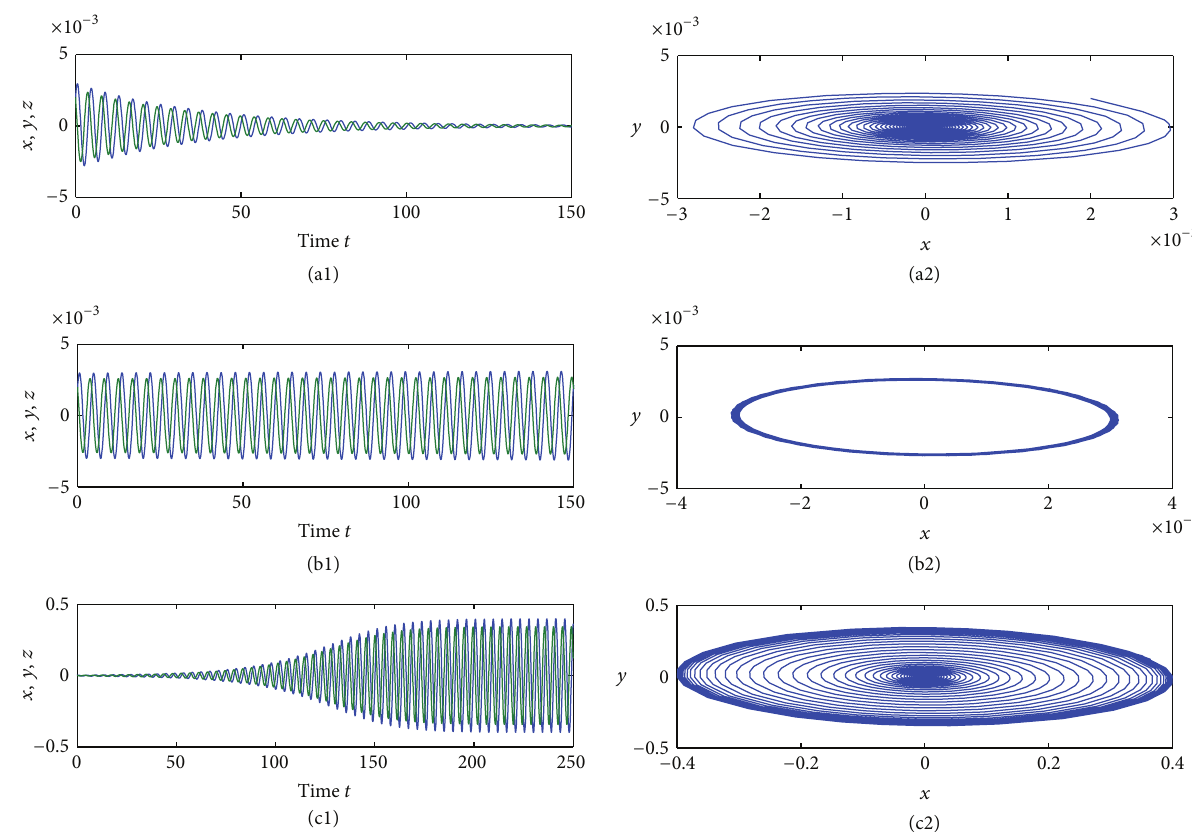
Figure 4: Time histories (a1, b1, and c1) and phase trajectories (a2, b2, and c2) of system (3) before, during, and after Andronov-Hopf bifurcation. In (a1) and (a2), 𝜏 = 0.233164320601144 < 0.253164320601144 = 𝜏 ∗ , and then the origin is locally asymptotically stable. In (b1) and (b2), 𝜏 = 0.253164320601144 = 𝜏 ∗ , and then there exists a periodic solution near the origin. In (c1) and (c2), 𝜏 = 0.283164320601144 > 0.253164320601144 = 𝜏